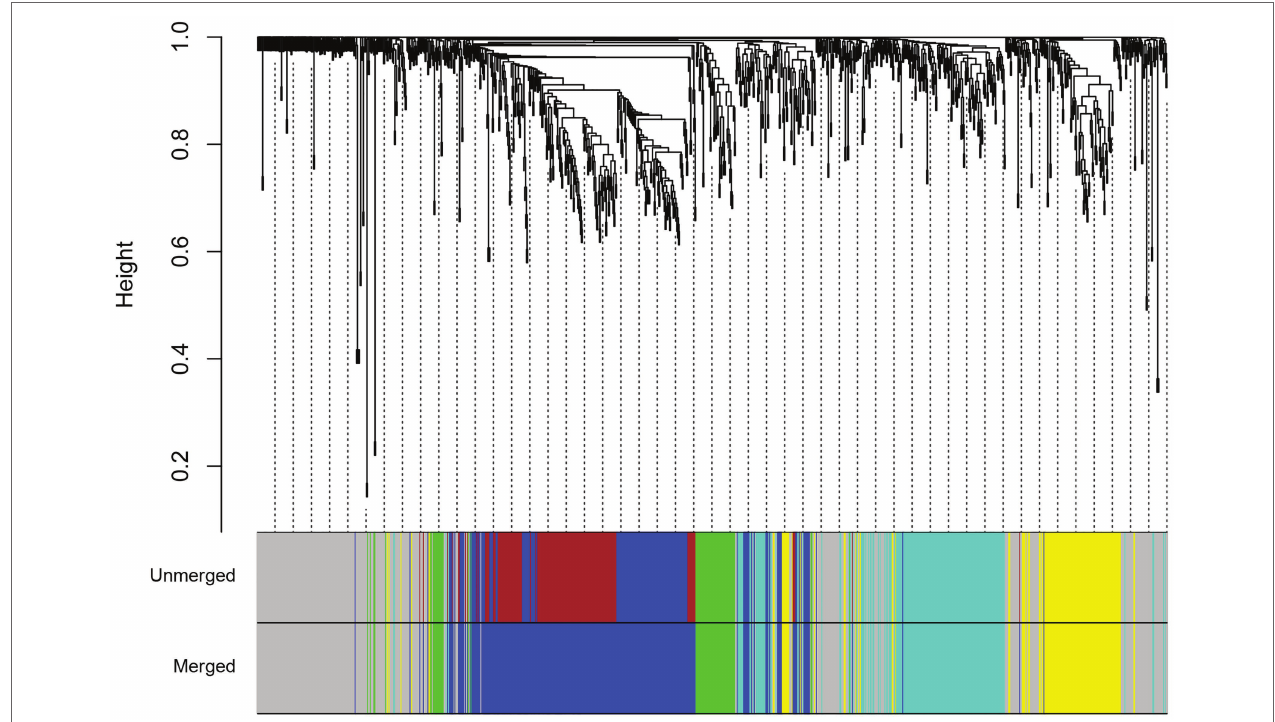
FIGURE 4 | Hierarchical clustering tree for consensus modules identified by weighted gene co-expression network analysis (WGCNA). The color labels correspond to the different consensus modules identified between maize ( Z. mays ) and rice ( O. sativa